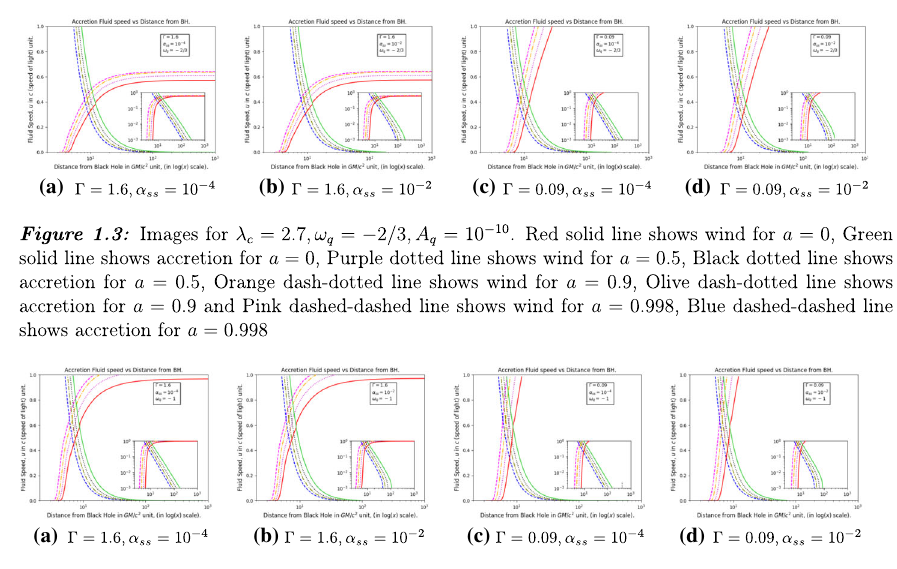
Fig. 1 Curves for fluid speed vs radial distance from the BH. 1.1 Images for λ c = 2 . 7 ,ω q = 1 / 3 , A q = 0 . 01. Red solid line shows wind for a = 0,Greensolidlineshowsaccretionfor a = 0,Purpledottedline shows wind for a = 0 . 5, Black dotted line shows accretion for a = 0 . 5, Orange dash-dotted line shows wind for a = 0 . 9, Olive dash-dotted line shows accretion for a = 0 . 9 and Pink dashed-dashed line shows wind for a = 0 . 998, Blue dashed-dashed line shows accretion for a = 0 . 998. 1.2 Imagesfor λ c = 2 . 7 ,ω q = 0 , A q = 0 . 01.Redsolidlineshowswind for a = 0,Greensolidlineshowsaccretionfor a = 0,Purpledottedline shows wind for a = 0 . 5, Black dotted line shows accretion for a = 0 . 5, Orange dash-dotted line shows wind for a = 0 . 9, Olive dash-dotted line shows accretion for a = 0 . 9 and Pink dashed-dashed line shows wind for a = 0 . 998, Blue dashed-dashed line shows accretion for a = 0 . 998.